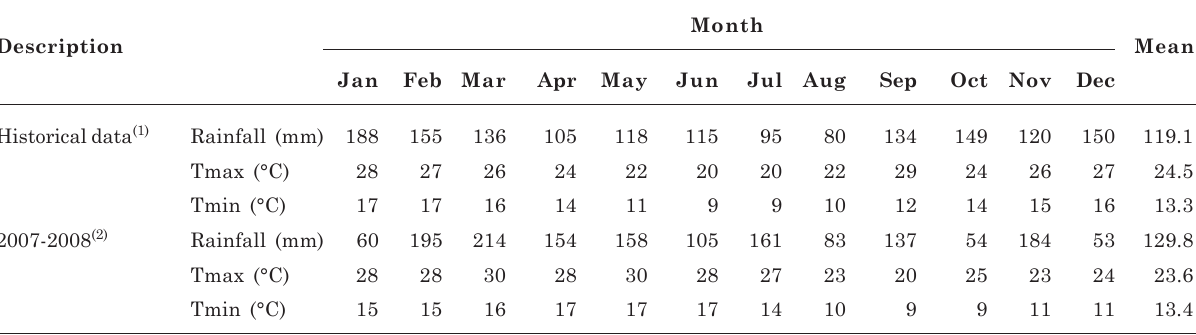
(1) Historical data for Ponta Grossa collected from January to December over 44 years. (2) Data collected during the experimental period from October 2007 to September 2008.